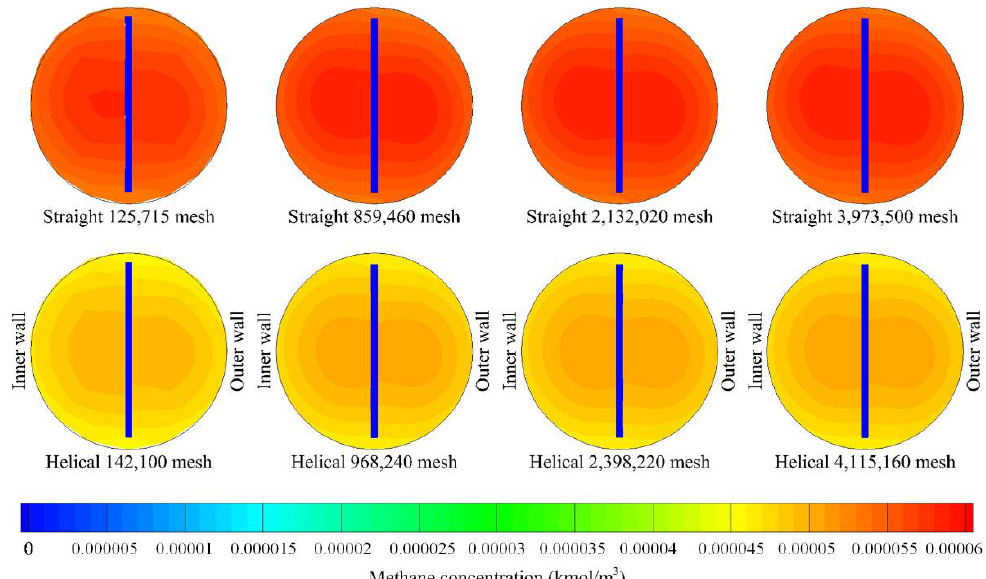
Figure 12. Methane concentration (kmol/m 3 ) of reactant flow in straight and helical square with twisted tape insert ( y = 3.15) at L = 25.16 mm and Reynolds number of 1000 for various meshes.